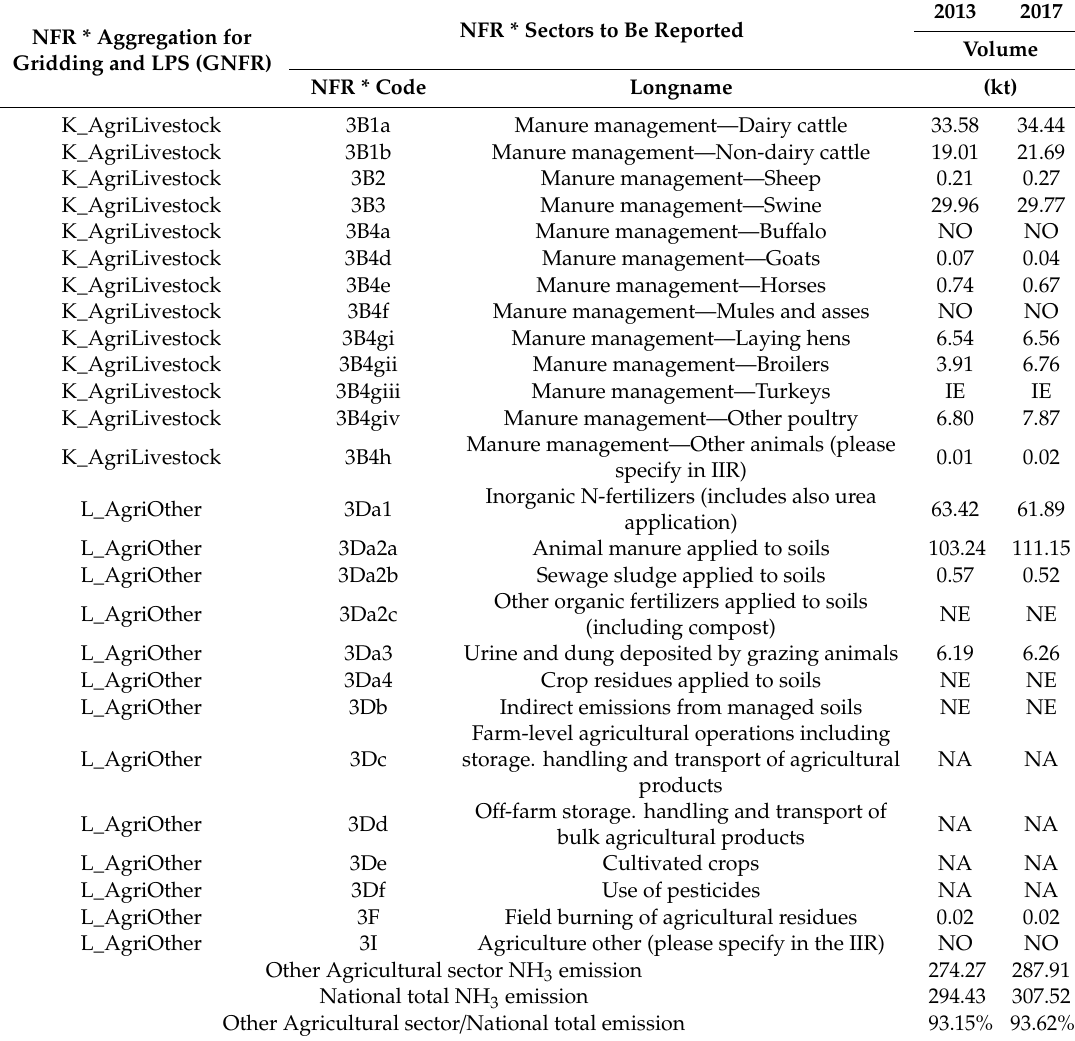
Table 4. The volume of ammonia emissions and the place of origin of these emissions from agricultural sources in Poland in 2013 and 2017